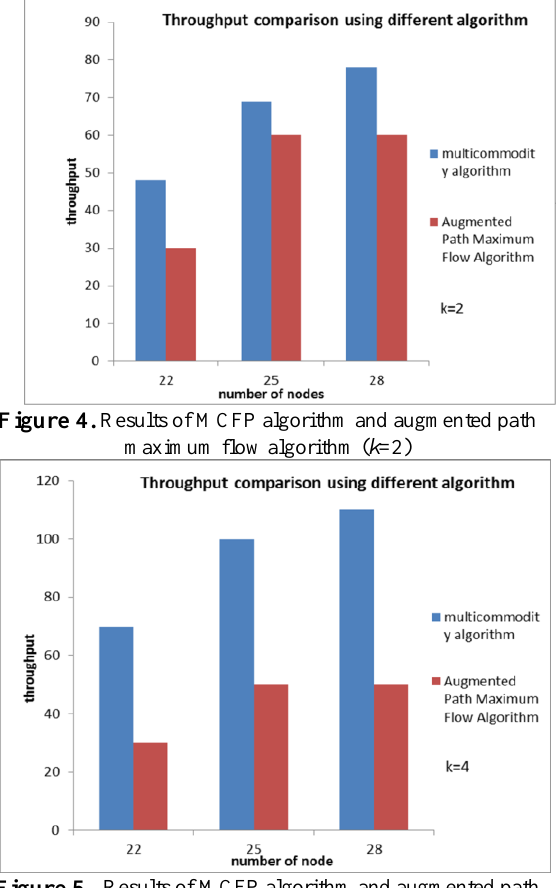
Figure 5. Results of MCFP algorithm and augmented path maximum flow algorithm ( k =4)